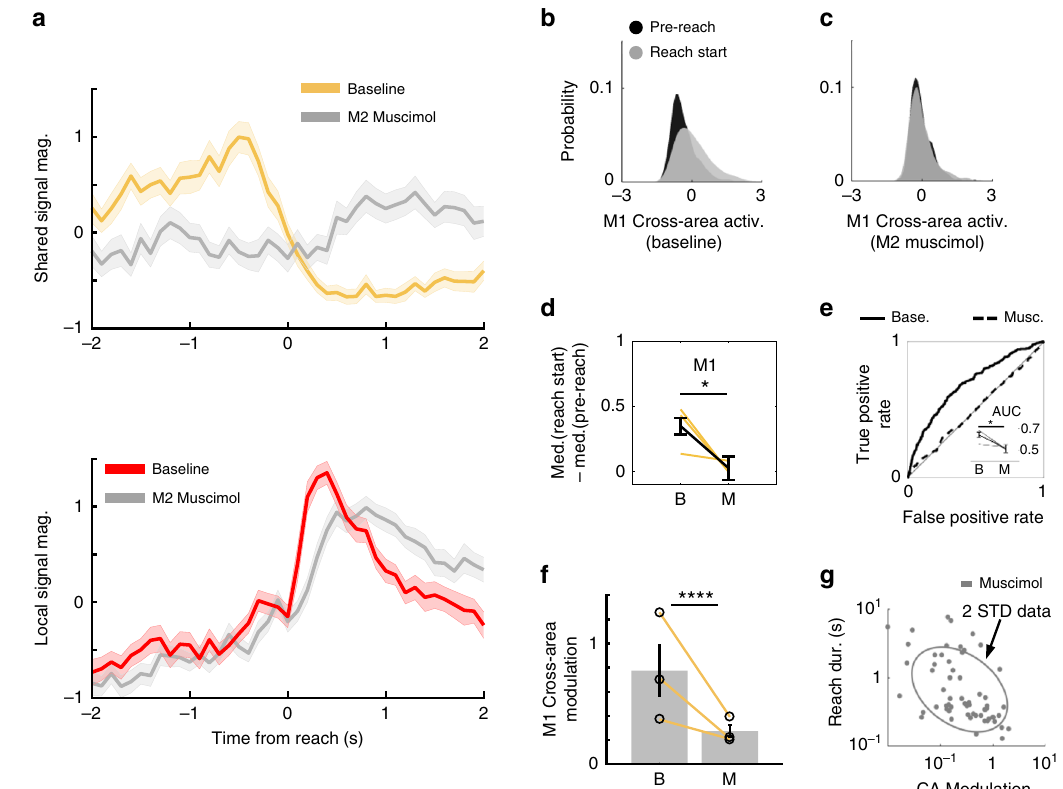
Fig. 8 M2 inhibition disrupts M1 cross-area movement modulation. a (Top) Comparison of z -scored, trial-averaged M1 cross-area activity magnitudes during baseline (yellow) and M2 inactivation (gray) for one example animal. M1 CCA weights were de fi ned during baseline period and used to calculate cross-area activity during both baseline and M2 inactivation trials. Solid line shows mean and shaded region shows standard error of the mean. (Bottom) As above, but for M1 local signals during baseline (red) and M2 inactivation (gray), suggesting that local signals are not as impacted by M2 inactivation. n = 91 trials for Baseline, n = 92 trials for M2 Muscimol. b Probability density function of M1 cross-area neural activity during baseline trials. Pre-reach activity in black. Reach start activity in gray. c As in b , but during M2 inactivation trials. d Quanti fi cation of ( b , c ) as the difference between median pre- reach and reach activity during baseline and M2 inactivation trials in M1 cross-area subspace. Yellow lines show data from individual animals, black line shows mean ± SEM, n = 3 rats. p = 0.02. * p < 0.05. two-sided t -statistic, not adjusted for multiple comparisons. e Detection of reach initiation from M1 cross-area subspace activity using ROC analysis on logistic regression model (example animal). (Inset) Difference in reach detection quanti fi ed as the area under the curve (AOC) for all animals. Gray lines show data from individual animals; black lines show mean ± SEM, n = 3 rats. p = 0.02. * p < 0.05. two- sided t -statistic, not adjusted for multiple comparisons. f M1 cross-area activity (CA) modulation decreases signi fi cantly with M2 inactivation. Yellow lines, also marked with black open circles, show data from individual animals, bars show mean ± std dev., n = 3 rats. **** p < 0.0001. One-sided hierarchical bootstrap, not adjusted for multiple comparisons. g Single-trial M1 CA-modulation predicts single-trial reach duration even during M2 inactivation. Plot shows random subsampling of trials across animals, all trials were used in quanti fi